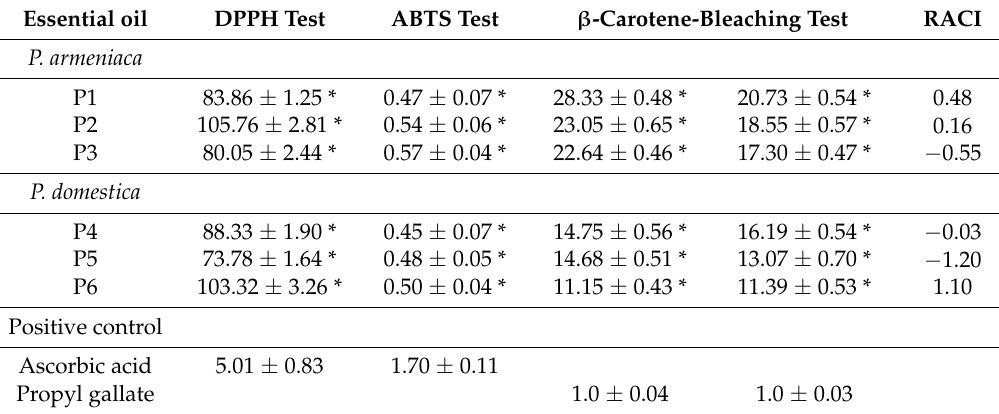
Table 2. Antioxidant activity (IC 50 , µ g/mL) evaluated by 2,2-diphenyl-1-picrylhydrazyl (DPPH), 2,2’-azino-bis(3-ethylbenzothiazoline-6-sulphonic acid) (ABTS), β carotene-bleaching test and Relative Antioxidant Capacity Index (RACI)